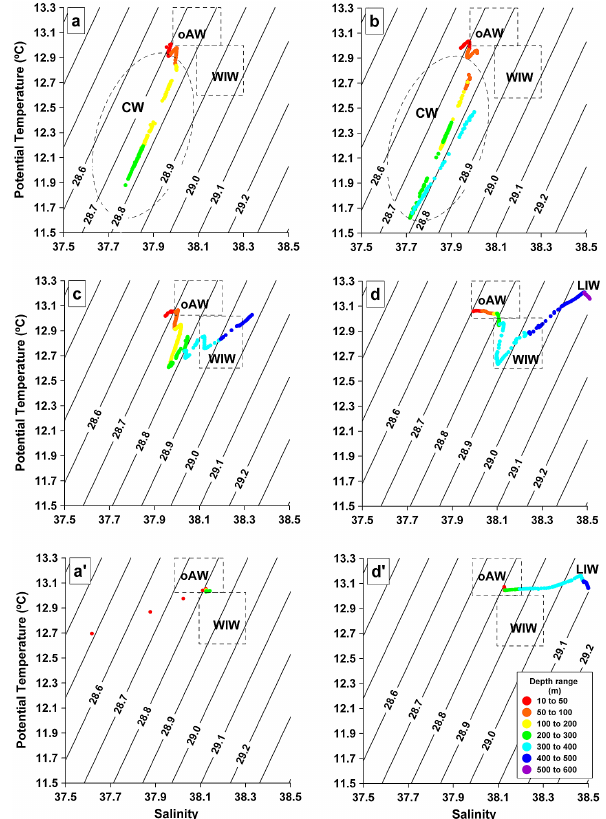
Fig. 11. T/S diagrams from selected vertical profiles (see Fig. 6 for positions) conducted during two CTD transects across Cap de Creus Canyon on 14 March (a, b, c, d) and 21 March (a’, d’) 2011. CW=coastal waters; WIW=Western Intermediate Waters; oAW=Old Atlantic Water; LIW=Levantine Intermediate